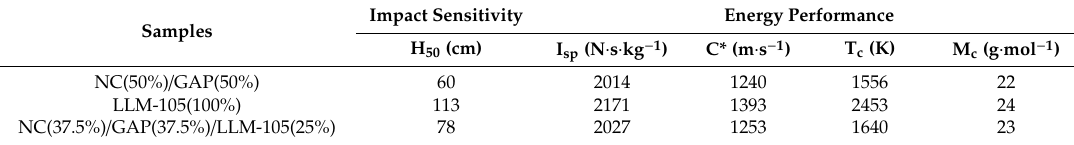
Table 5. Impact sensitivity and energy performance of the samples.